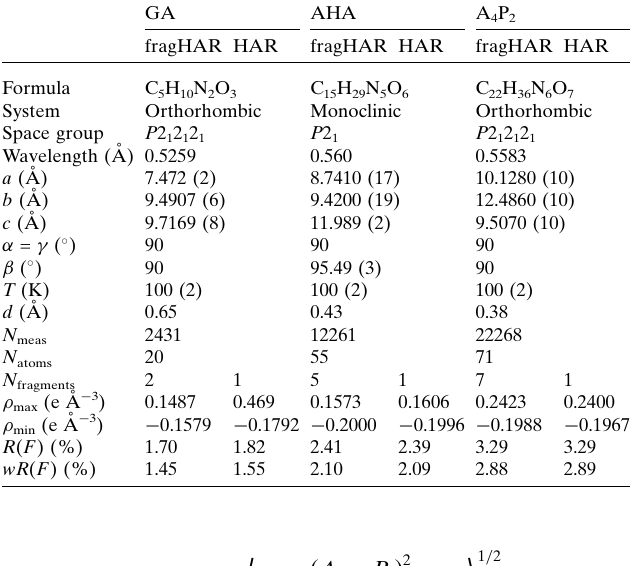
Table 1 Crystallographic refinement details for fragHAR versus HAR obtained using Hartree–Fock wavefunctions with the cc-pVDZ basis